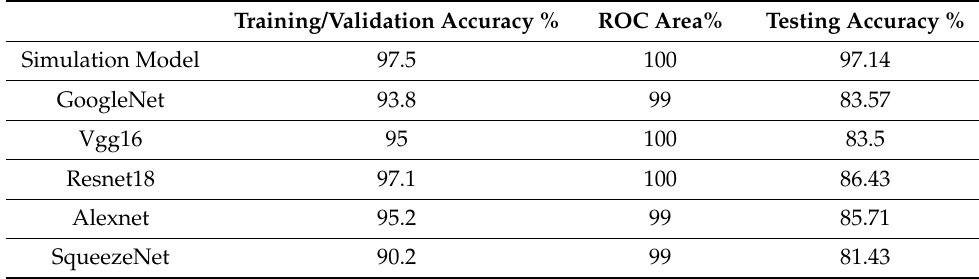
Table 2. Comparison of the customized pretrained simulation model with existing pretrained deep learning models (12 virtual sensors and cubic